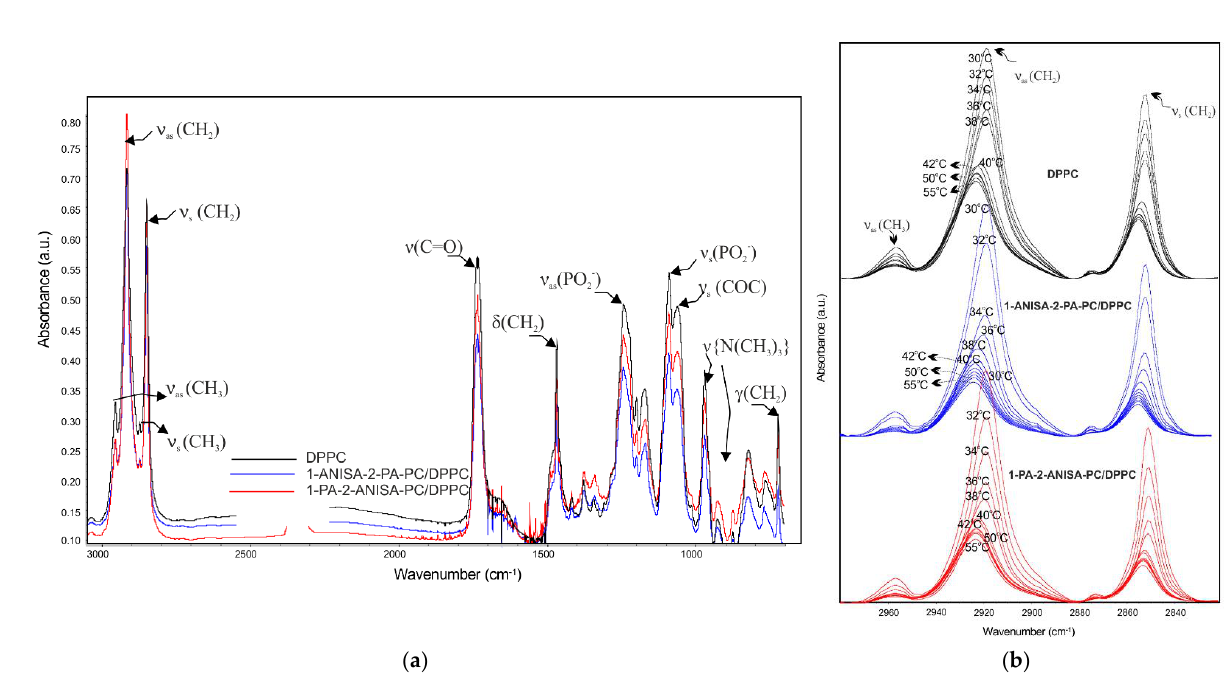
Figure 5. ATR-IR spectra of dehydrated DPPC film (control) and dehydrated conjugates/DPPC film at 25 °C with the assignment of the main absorption bands of DPPC. ( a ) Selected ATR-IR spectra of hydrated DPPC bilayer (control) and hydrated conjugates/DPPC bilayer in the hydrocarbon chains region at different temperatures. ( b ) The conjugate:DPPC molar ratio of